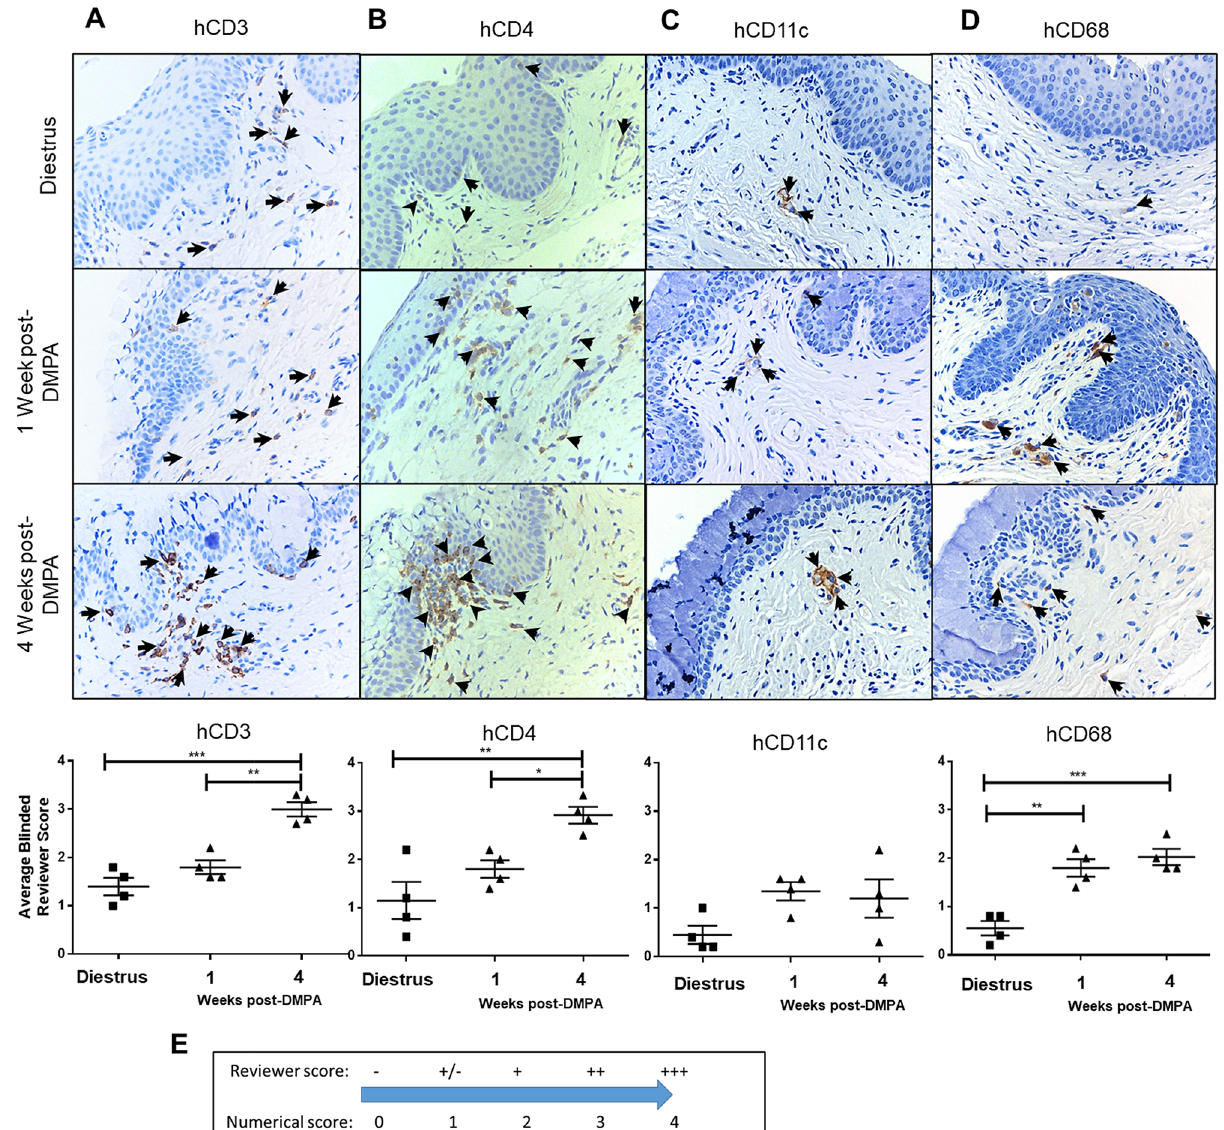
Figure 6. Macrophages are initially enhanced in the vaginal tract of DMPA-treated Hu-mice. Immunohistochemical staining (brown stain, arrowheads) for HIV-1 target cells ( A ) hCD3, ( B ) hCD4, ( C ) hCD11c (DCs), and ( D ) hCD68 (macrophages) was performed on the vaginal mucosa of uninfected Hu-mice in diestrus (N = 5), 1 week (N = 6), and 4 weeks post-DMPA (N = 5). Slides were independently scored by 4 reviewers blinded to treatment, according to the scoring continuum ( E ). DMPA treatment enhanced hCD3 ( A ) ( P = 0.0001, one-way ANOVA), hCD4 ( B ) ( P = 0.0036, one-way ANOVA), and ( D ) hCD68 populations ( P = 0.0003, one-way ANOVA), while hCD11c ( C ) remained constant ( P = 0.0959, one-way ANOVA). The only HIV-1 target cell population that was significantly different between Hu-mice in diestrus and 1 week post- DMPA (time point corresponding to when we would typically challenge Hu-mice with HIV-1) was hCD68+ cells, suggesting DMPA-treated Hu-mice are initially more susceptible to intravaginal infection with HIV-1 due to increased vaginal macrophages. * P ≤ 0.05. ** P ≤ 0.01. *** P ≤ 0.001. Data are presented as mean ± SEM. DMPA Depot-medroxyprogesterone